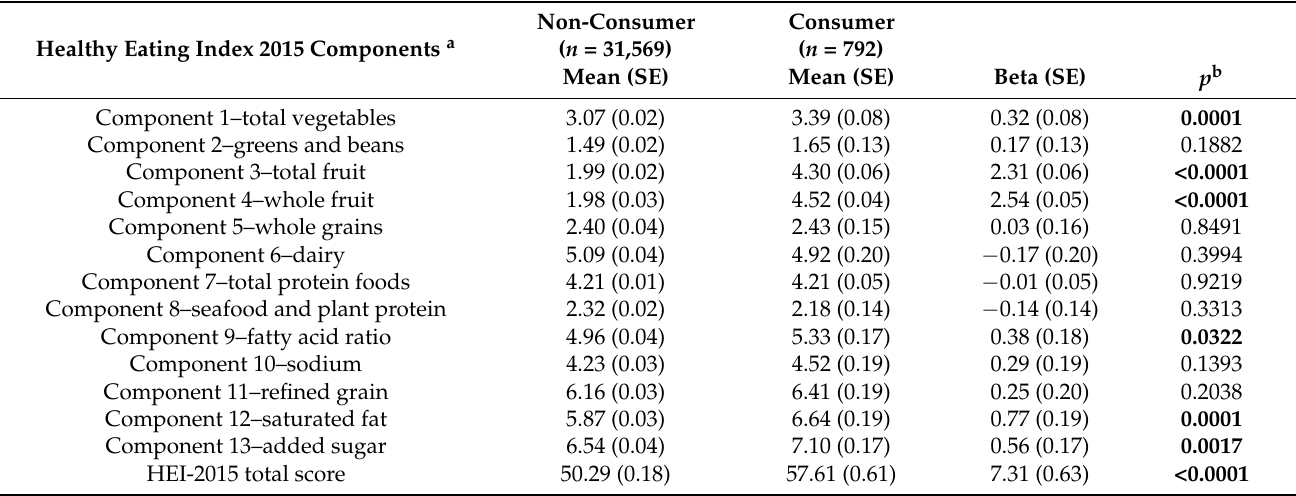
Table 5. Association of watermelon consumption with Healthy Eating Index-2015 total and sub- component score in adults, NHANES 2003–2018, gender combined data.